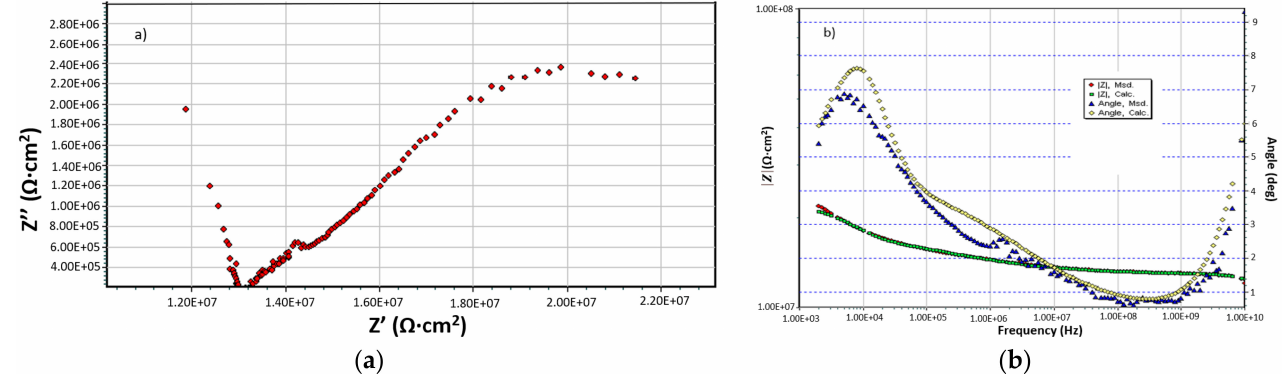
Figure 4. Nodular cast iron immersed for 65 days in DWW-2: ( a ) Nyquist plot and ( b ) Bode